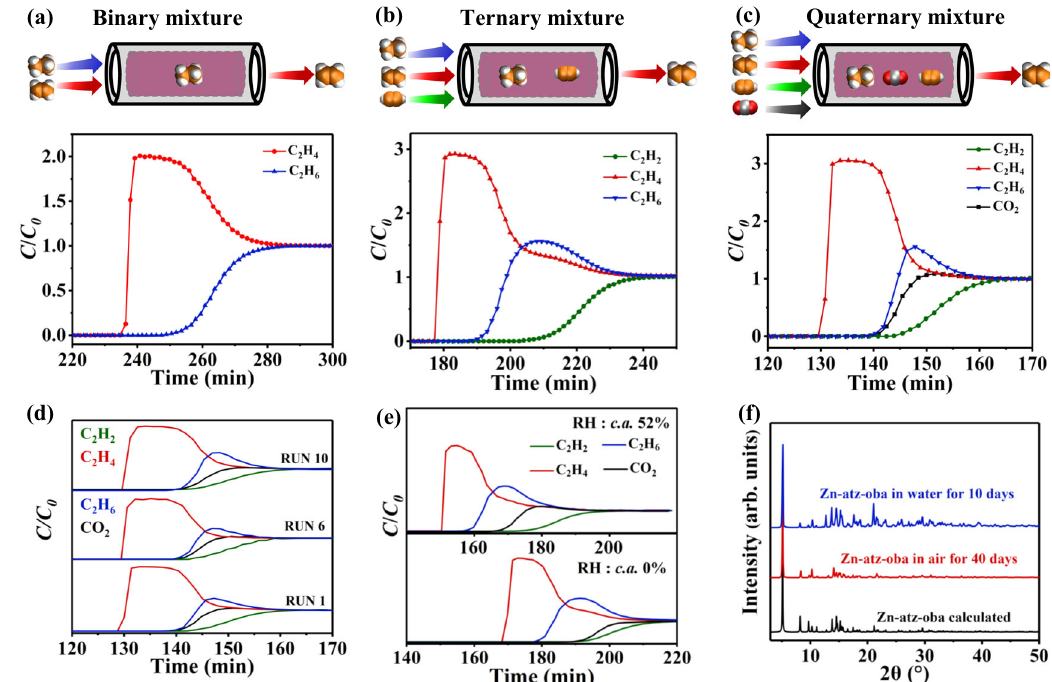
Fig. 4 Dynamic breakthrough experiments and stability tests. ( a ) – ( c ) Experimental breakthrough curves at 298 K for C 2 H 4 /C 2 H 6 (1:1) ( a ), C 2 H 2 /C 2 H 4 / C 2 H 6 (1:1:1) ( b ), and C 2 H 2 /C 2 H 4 /C 2 H 6 /CO 2 (1:1:1:1) ( c ) separations (equimolar mixtures; total gas pressure 100 kPa; total gas fl ow 1.4, 2.1 and 2.8 cm 3 min − 1 , respectively) based on Zn-atz-oba (6.3 g) packed column (C: Outlet gas concentration, C 0 : Inlet gas concentration). ( d ) Dynamic breakthrough data obtained with Zn-atz-oba fi xed-bed in 1 st , 5 th , and 10 th cycle when subjected to four-component C 2 H 2 /C 2 H 4 /C 2 H 6 /CO 2 (1:1:1:1) mixture. e Four- component (1:1:1:1) breakthrough experiment in the presence of water vapor at 288 K and 100 kPa based on Zn-atz-oba (7.0 g) packed column (total gas fl ow of 2.8 cm 3 min − 1 ). ( f ) PXRD patterns of Zn-atz-oba after being subjected to air exposure and water immersion stability test